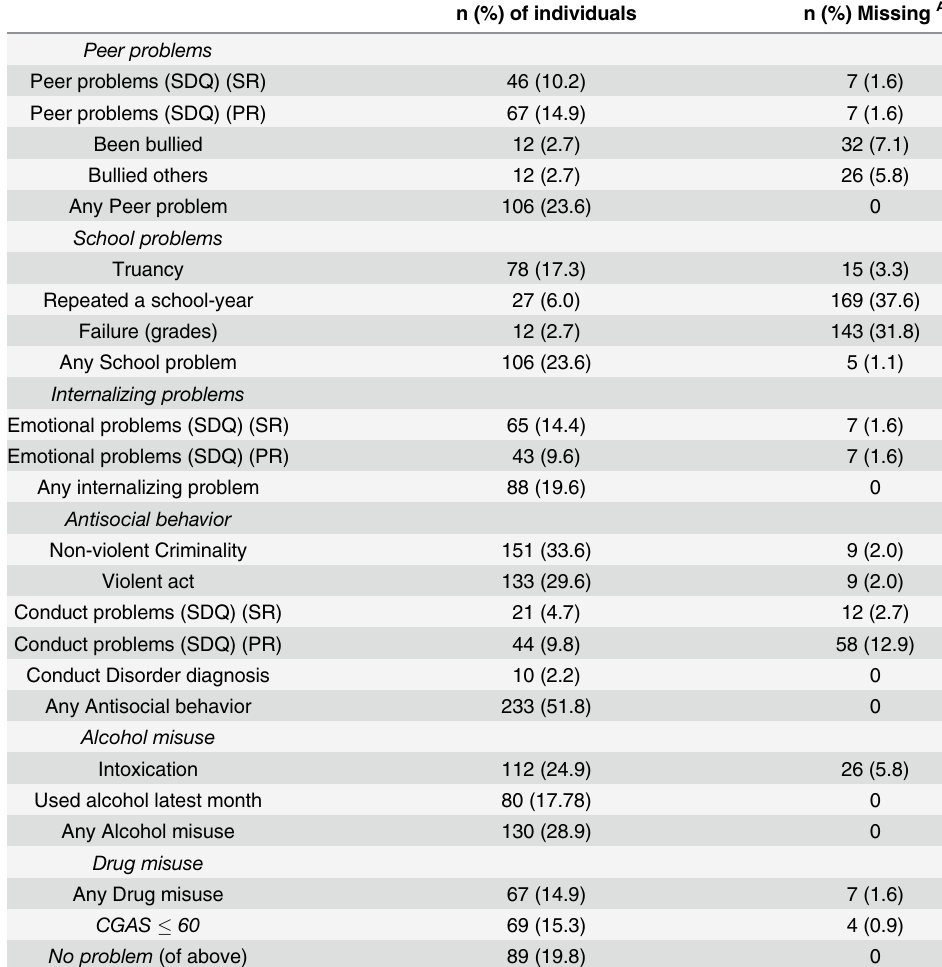
Table 2. Distribution of age 15 psychosocial outcomes in the whole cohort (n =